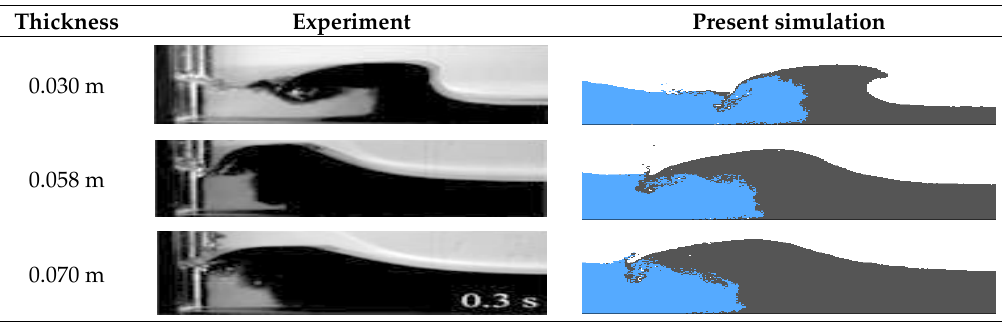
Figure 8. Comparison between the experiment and numerical simulation with various thicknesses of the soil bed at 0.3 s.